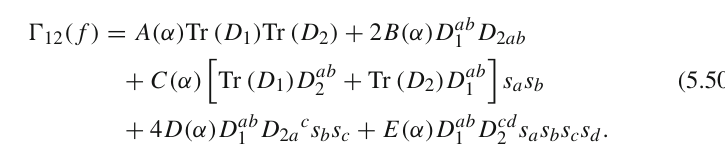
(cid:13) ( f ) = A (α) Tr ( D 12